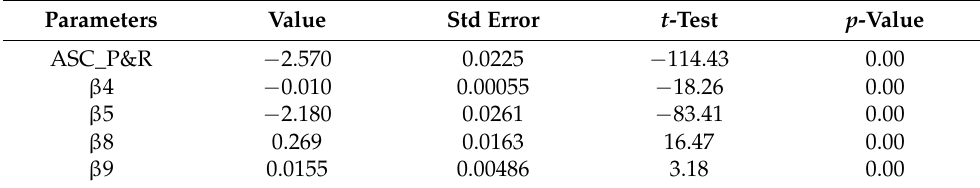
Table 2. Calibrated values of binomial logit parameters and statistical significance of the